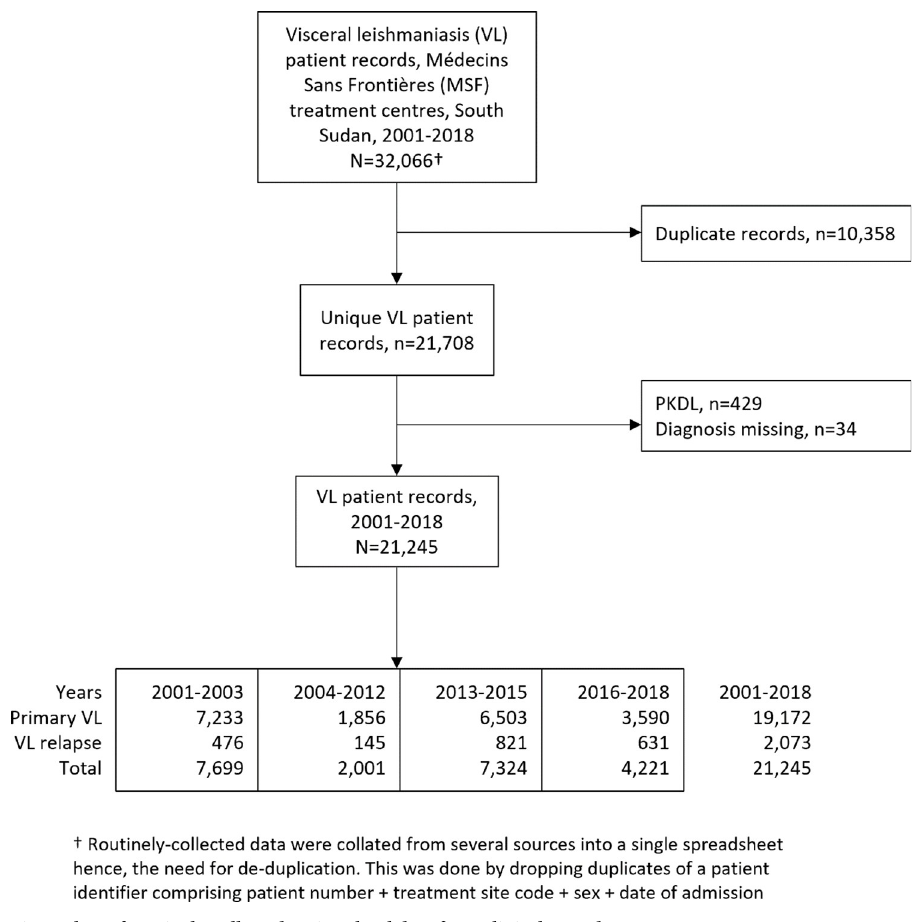
Fig 2. Flow of routinely-collected patient-level data from clinical